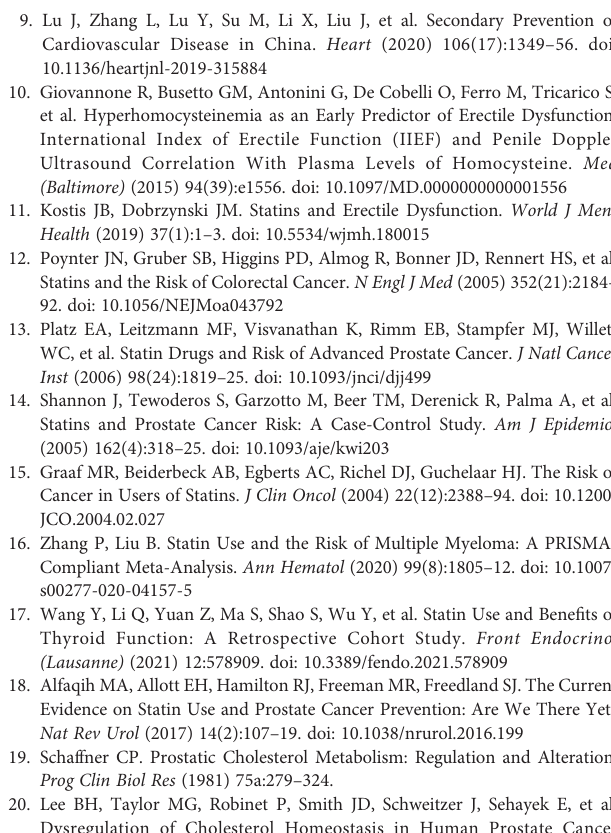
Supplementary Figure 1 | The forest plot for subgroup analyses. (A) The forest plot for the RR of BCR with subgroup analyses by primary treatment. (B) The forest plotfortheRRofBCRwithsubgroupanalysesbycountry. (C) Theforestplotforthe HR of BCR with subgroup analyses by country. Supplementary Figure 2 | The meta-regression for HR of BCR and covariates. (A) Tumor stage. (B) GS. (C) PSA. (D) The percentage of AA. (E) BMI<30. (F) BMI value. (G) Age. (H) Follow-up duration. (I) Publication year. Each dot represents an individual study. Symbol size represents sample size. Supplementary Figure 3 | The meta-regression for RR of BCR and covariates. (A) BMI<30. (B) BMI value. (C) PSA. (D) Tumor stage. (E) Publication year. (F) Age. (G) Follow-upduration. (H) ThepercentageofAA.Each dotrepresents anindividual study. Symbol size represents sample size. Supplementary Figure 4 | Sensitivity analysis and the detection of publication bias for included studies on RR of BCR. (A) Sensitivity analysis by stepwise omitting the included studies. (B) Cumulative meta-analysis by stepwise addingthe included studies. (C) The funnel plot. (D) The trim and fi ll funnel plot. (E) The fi lled forest plot. (F). The Galbraith plot. Effect size as z-scores plotted as a function of the inverse standard error for each study reported in the present study. The middle line is the line of best fi t, while upper and lower dashed lines represent the upper and lower 95% con fi dence limits. (G) The L ’ Abbe ́ plot for incidence of BCR. Each dot represents an individual study. Symbol size represents sample size. Supplementary Table 3 | Univariable meta-regression for the RR of biochemical